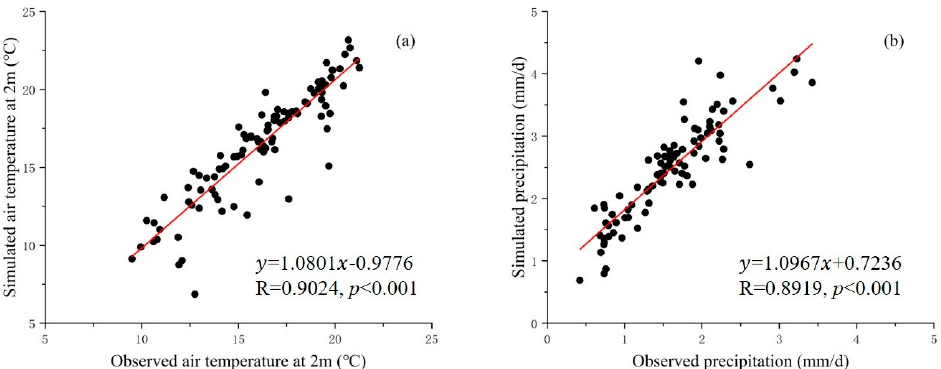
Figure 3. Relationship between simulated T2 and observed T2 ( a ), simulated precipitation and observed precipitation ( b ), from 2011 to 2018.